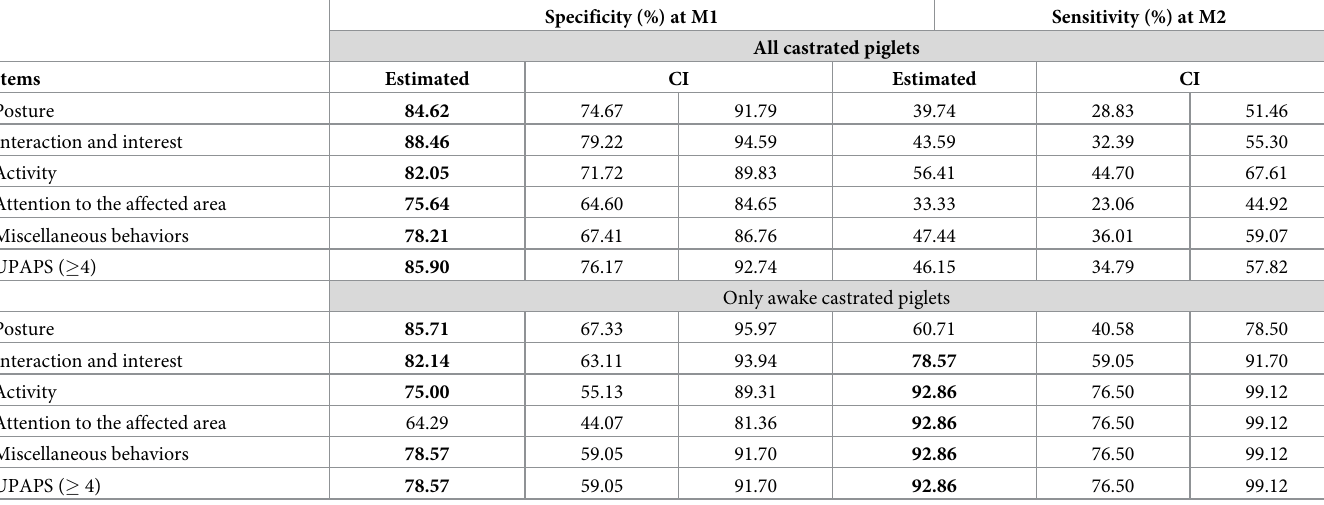
Table 6. Specificity and sensitivity and 95% confidence interval (CI) of the UPAPS applied for all castrated piglets (n = 39) and awake castrated piglets (n =